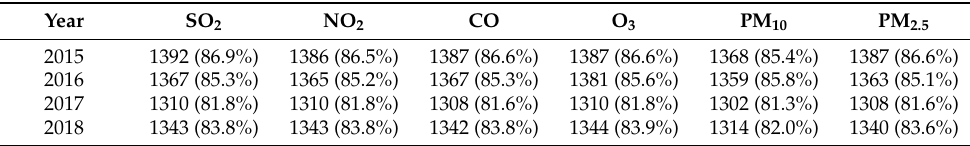
Figure 1. Locations of effective monitoring stations of CO, NO 2 , SO 2 , 8 h O 3 , PM 10 , and PM 2.5 in China during 2015–2018 (except Hong Kong, Taiwan, and Macao). The blue dots indicate locations of invalid monitoring stations (number of missing days/total number of days in the year ≥ 5%); the red dots indicate locations of effective monitoring stations (number of missing days/total number of days in the year < 5%). Table 2. Statistics of effective monitoring stations and the ratio of the total monitoring stations for CO, NO 2 , SO 2 , 8 h O 3 , PM 10 and PM 2.5 , respectively.